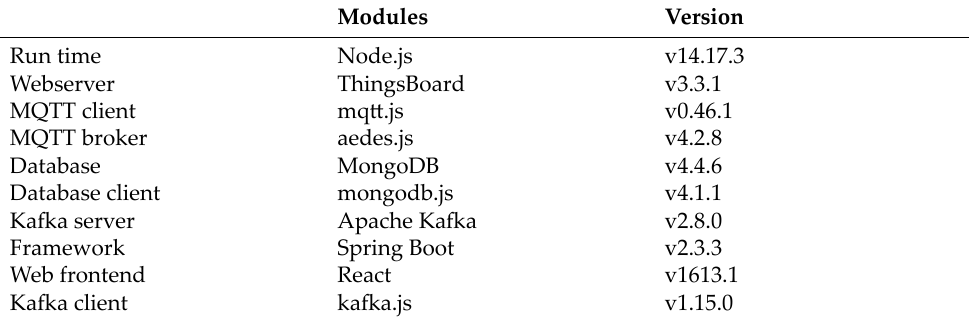
Table 2. Libraries and modules for system